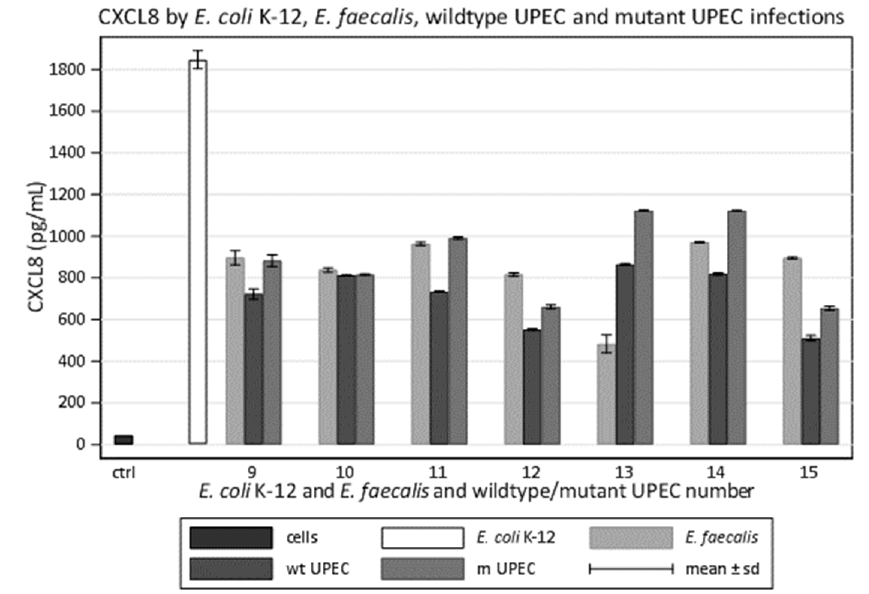
Figure 3. Values of CXCL8 induced in 5637 bladder epithelial cell line by monomicrobial infections from the seven wildtype UPEC compared to CXCL8 induced by monomicrobial infections from the seven mutant analogues, with the common E. coli K-12 and with E. faecalis strains isolated from the same urine. wt, wildtype; m, mutant.